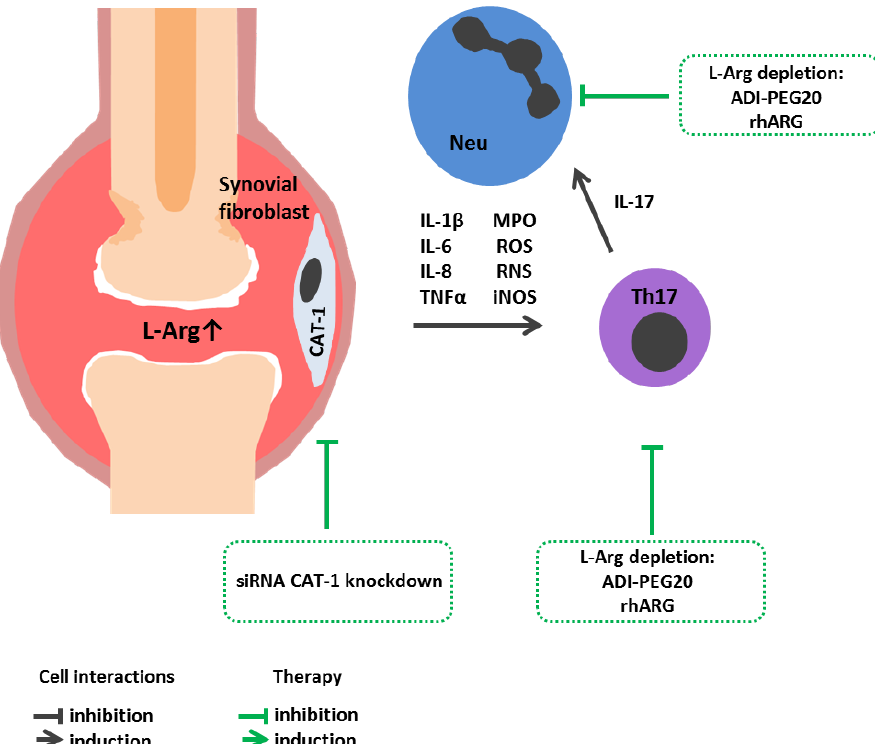
Figure 2. L-Arginine metabolism in rheumatoid arthritis immunopathogenesis and arginine-dependent processes as a target of therapeutic approaches. Increased synovial fluid L-Arg in RA patients correlates with IL-1 β , IL-6 and IL-8 levels. A high level of CAT-1 in sinovial fibroblasts increases L-Arg bioavailibility. A high L-Arg level promotes Th17 polarization and activation, which supports neutrophilic inflammation and cartilage destruction. Therapeutic strategies: CAT-1 knock-down with siRNA inhibite L-Arg uptake. L-Arg exhaustion with arginine-hydrolazing enzymes affects Th17 clonal expansion, iNOS activity and RNS production. ADI-PEG20, pegylated arginine deiminase; CAT-1, cationic amino acid transporter-1; IL, interleukin; L-Arg, L-arginine; Neu, neutrophil; rhARG, recombinant human arginase; siRNA, small interfering RNA; Th17, T helper 17.